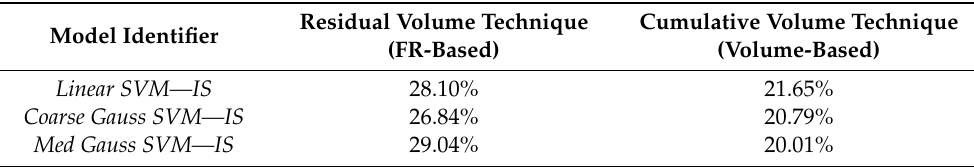
Table 6. Comparative mean overall absolute percentage error after 11 drinks: residual versus cumulative volume estimation approach.